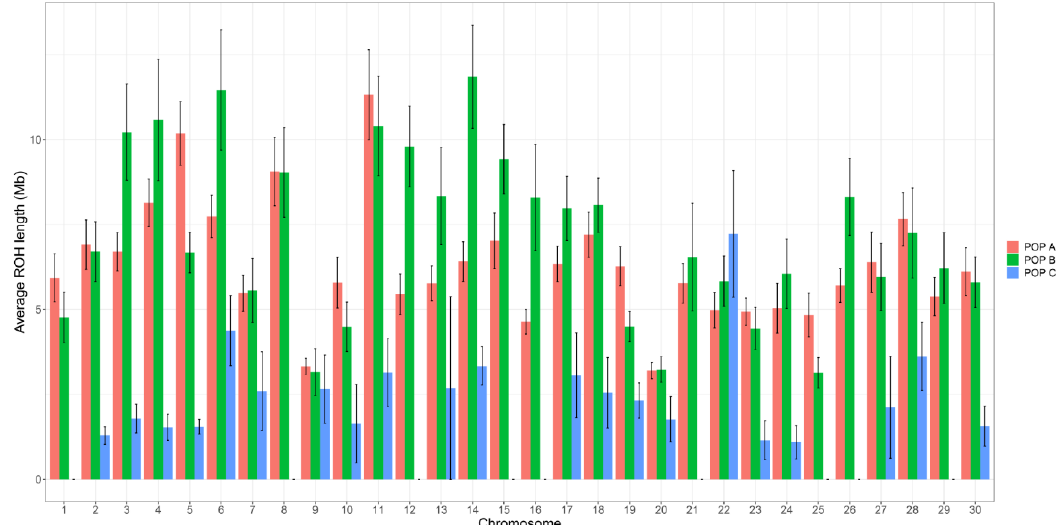
Figure 3. Average ROH length and standard error bars for each chromosome in three coho salmon populations.